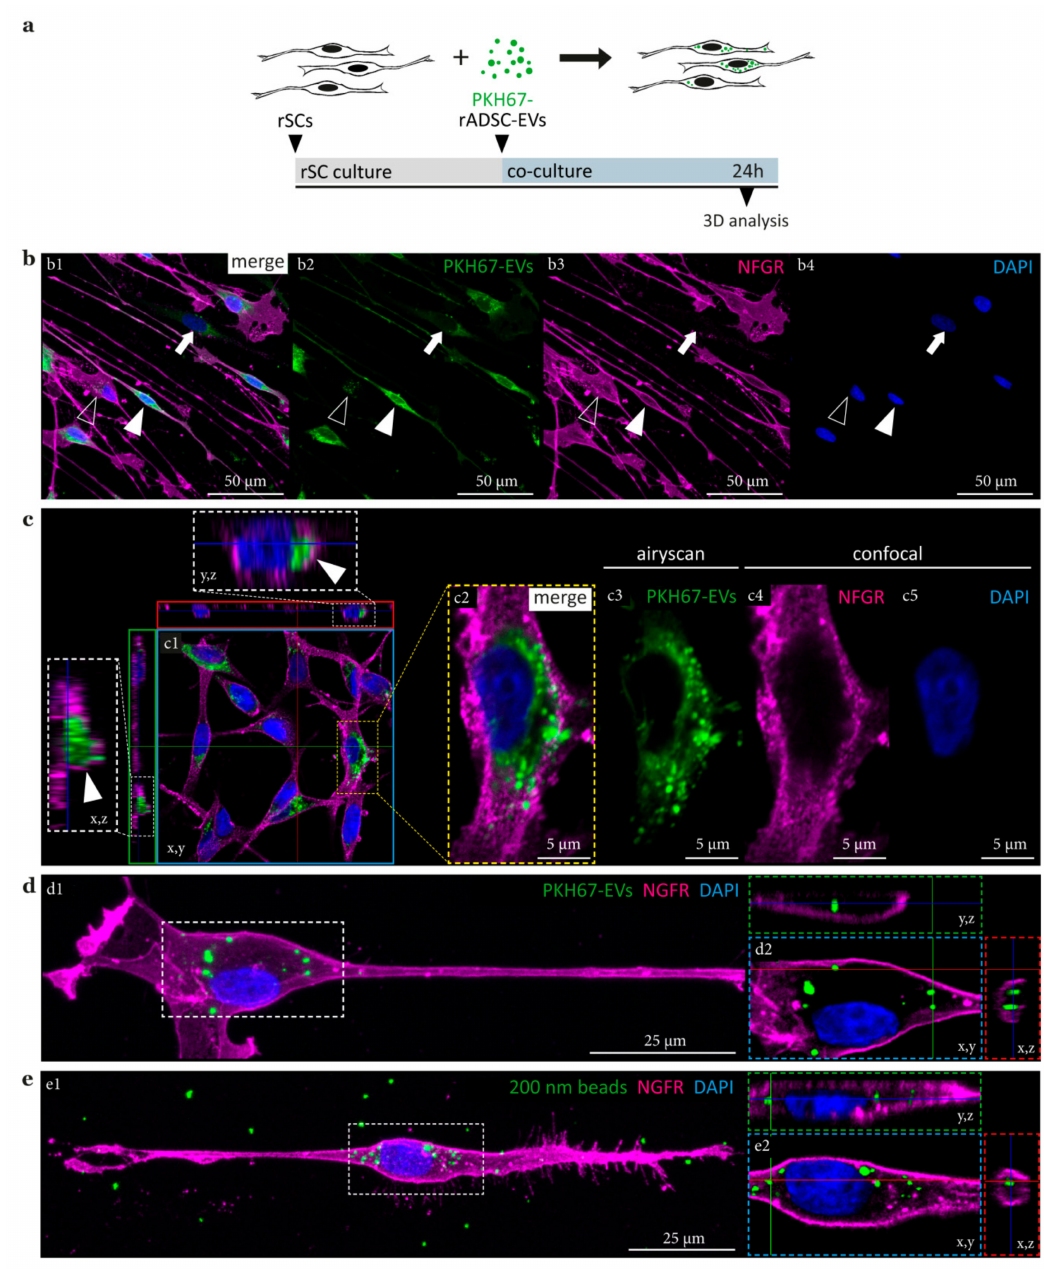
Figure 5. 3-D analysis of rSCs upon treatment with rADSC-EVs and silica beads. ( a ) Set up of the co-culture experiment. ( b , c ) Immunofluorescence images of rSCs co-cultured with rADSC-EVs for 24 h; merged channels ( b1 , c1 , c2 ) and single channels showing PKH67-labeled rADSC-EVs ( b2 , c3 ), NGFR ( b3 , c4 ) and DAPI ( b4 , c5 ) stainings. ( b ) Filled arrowheads indicate a rSC with intracellular staining signals of rADSC-EVs homogenously distributed within the SC body and processes; lined arrowheads indicate a rSC with rADSC-EV staining signals of a dotted appearance within the cell body; arrows indicate a rFB with rADSC-EV staining signals around the nucleus. ( c ) High resolution 3-D analysis of rADSC-EVs in rSCs. ( c1 ) Image represents a selected focal plane of a z-stack; arrows in y,z and x,z cross sections indicate rADSC-EVs within the cytoplasm; ( c2 ) Enlargement of ( c1 ) showing the Airyscan result for PKH67-EVs ( c3 ) as well as confocal images of NGFR ( c4 ) and DAPI ( c5 ) stainings. ( d , e ) Images of single rSCs after treatment with ( d1 ) PKH67-labeled rADSC-EVs and ( e1 ) green fluorescent 200 nm beads. Selected focal planes and cross sections of cell body enlargements for ( d2 ) PKH67-labeled rADSC-EVs and ( e2 ) 200 nm green fluorescent silica